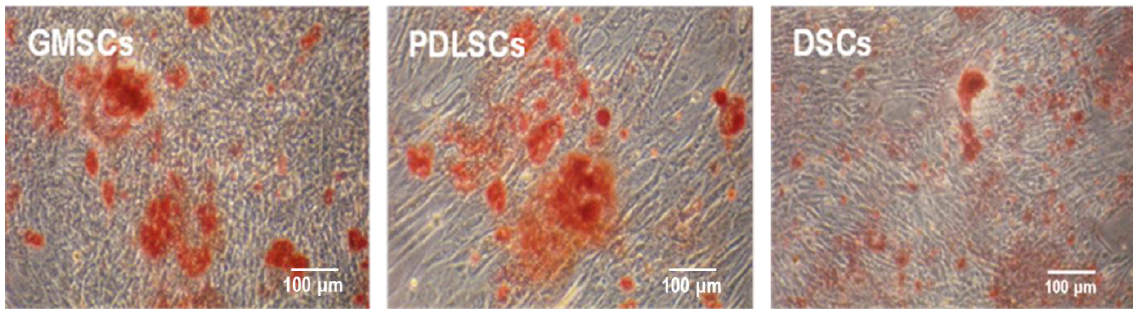
Figure 6. Mineralized nodule formation by GMSCs, PDLSCs and DSCs (P3) after three weeks of osteogenic induction.